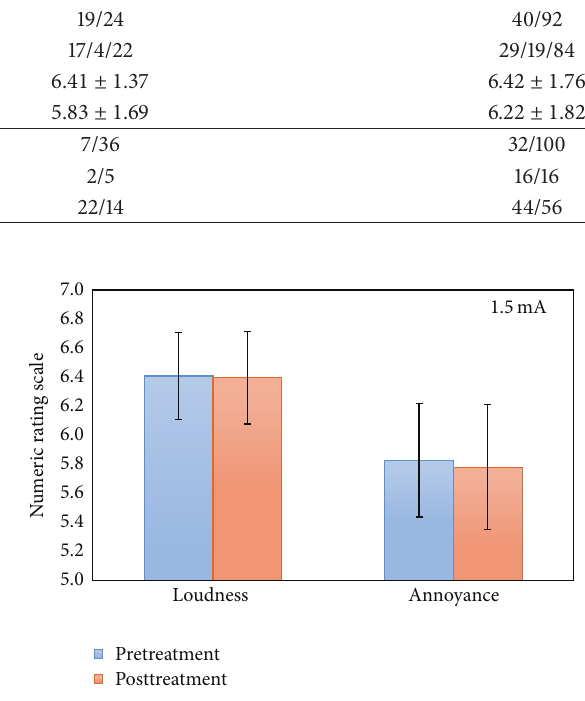
Figure 1: NRS loudness and annoyance pre- and posttreatment for the 1.5mA